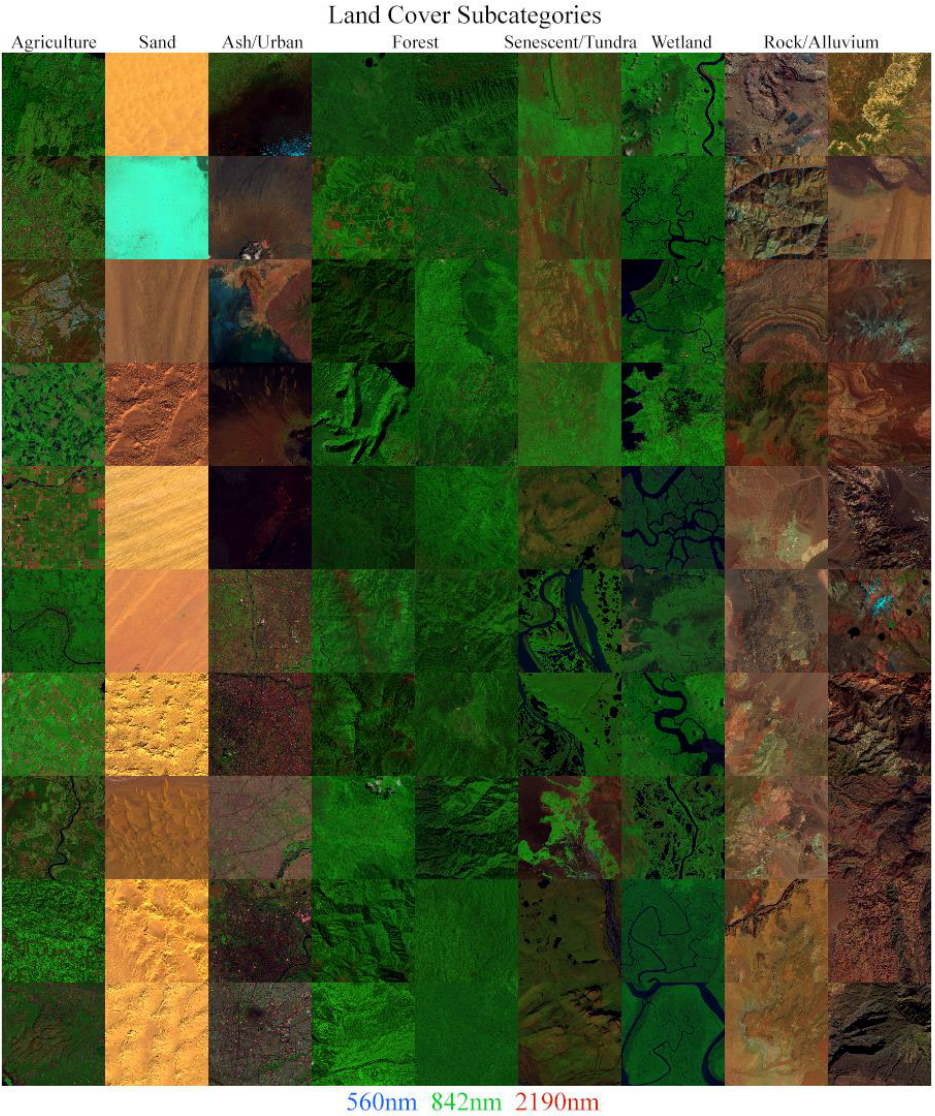
Figure 2. Sentinel-2 composites for land cover subcategories (10 × 10 km) selected from individual hotspot tiles. 1% linear stretch applied.